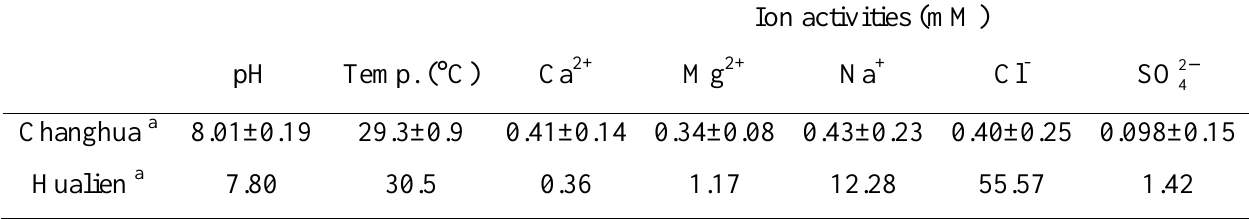
Table 2 Measured pH and temperature values with the ion activities of key water chemistry characteristics calculated by WHAM from published data for two selected clam farms of Changhua and Hualien